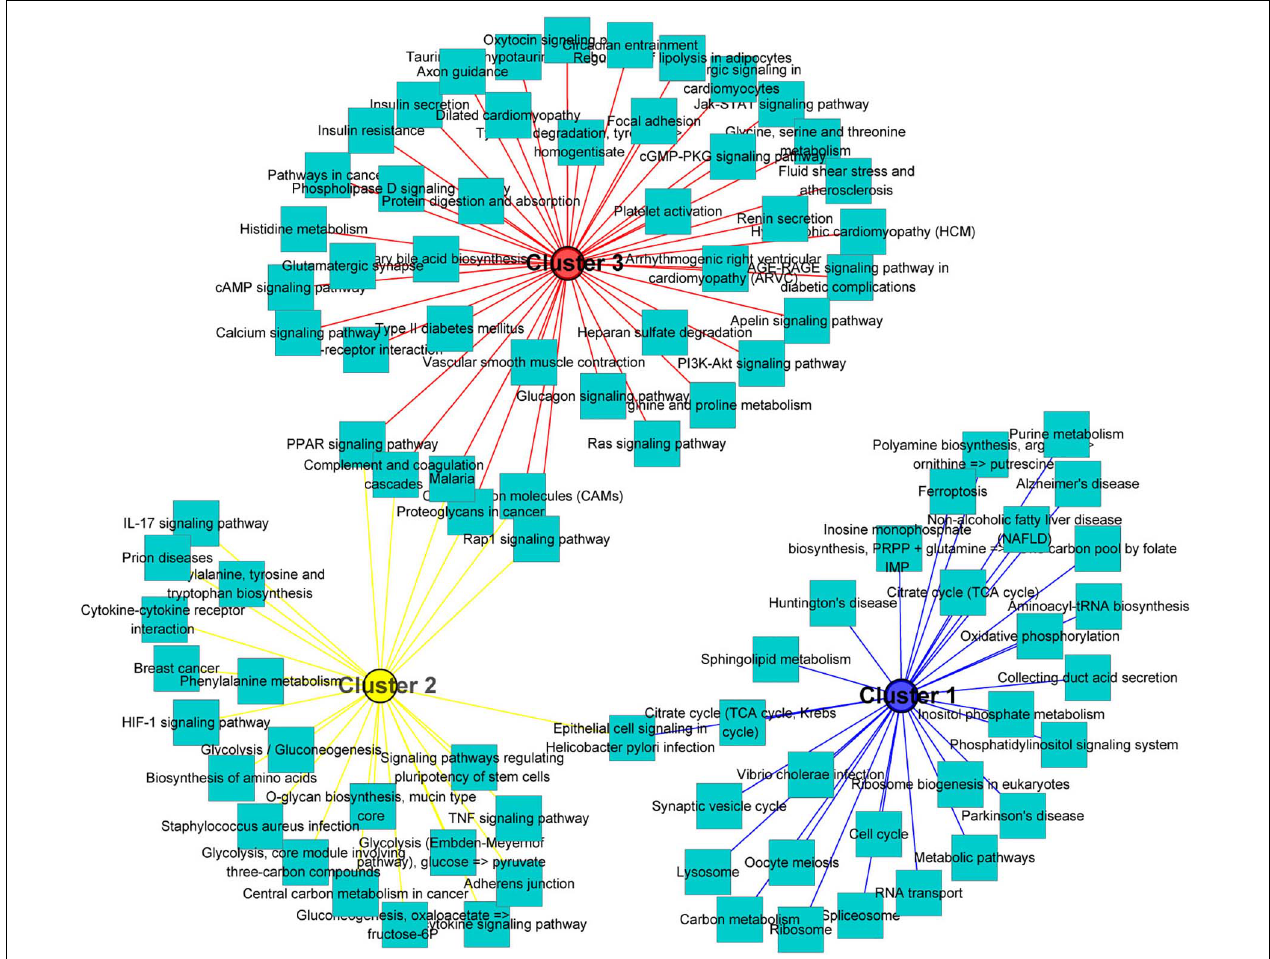
FIGURE 6 | KEGG pathways analysis of gene clusters. All significant differentially expressed genes across the three stages were used as input for the ToppCluster. The database “KEGG pathway” was used for analysis. Then, the data were uploaded in Cytoscape (v3.7.2) to generate the network. Each square node represents a pathway. Each cluster is represented by a different